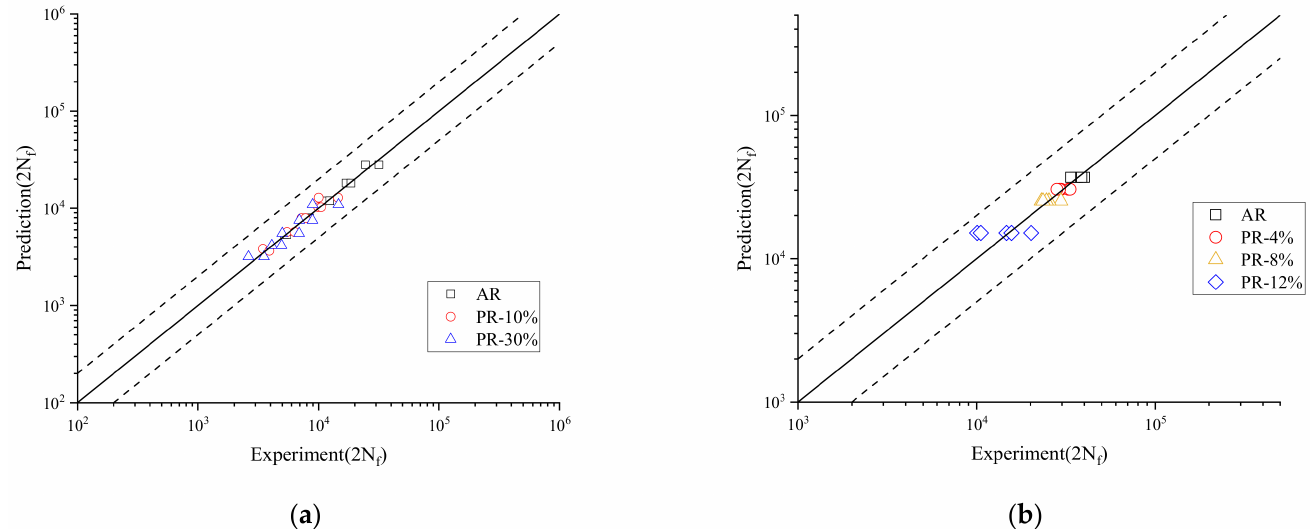
Figure 12. Comparison of fatigue life prediction. ( a ) Material steel Fe-18 Mn; ( b ) Material complex- phase steel